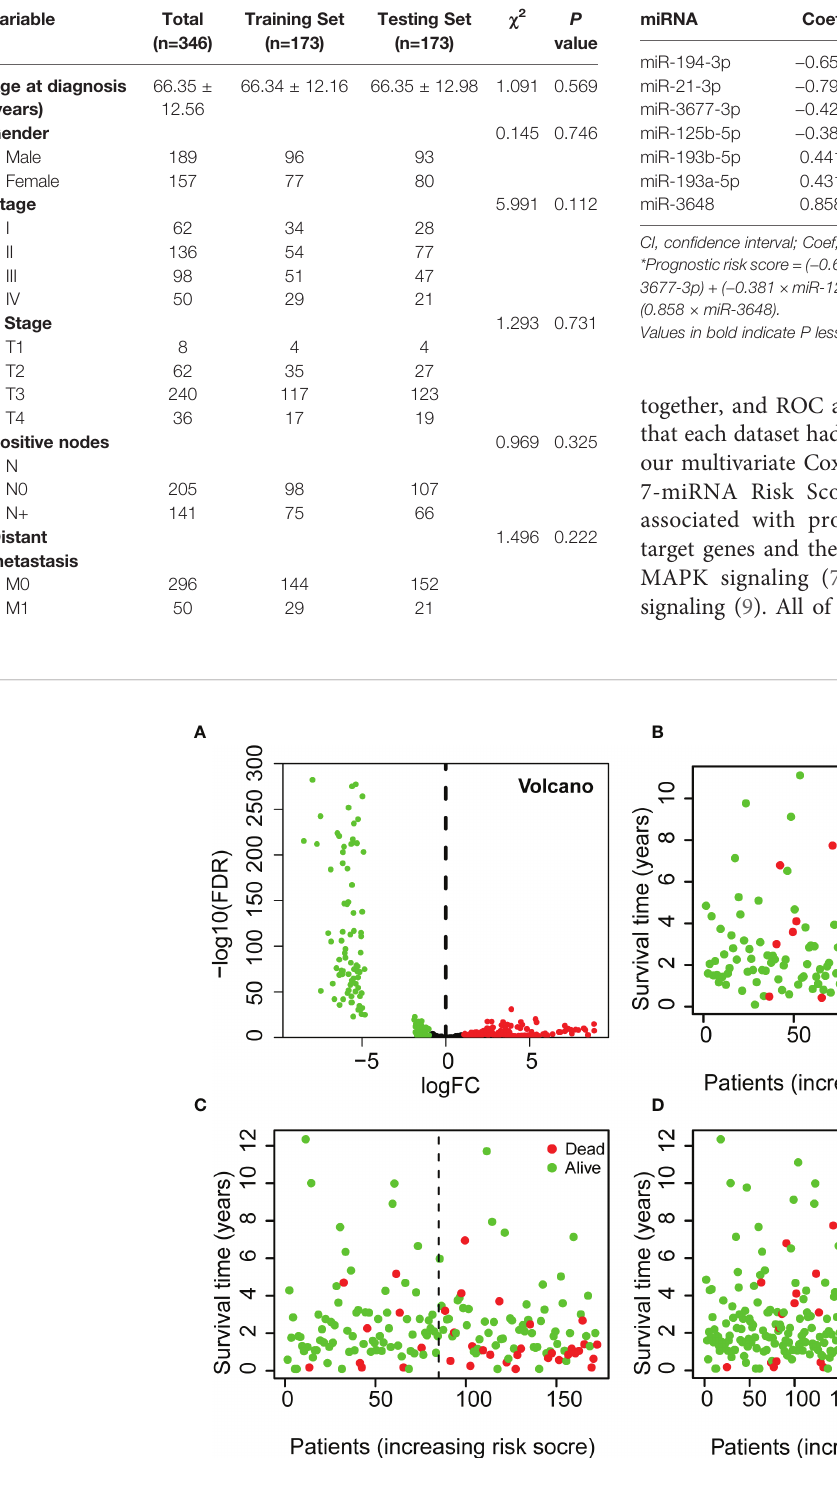
TABLE 1 | Demographic and clinical characteristics of COAD patients from TCGA.